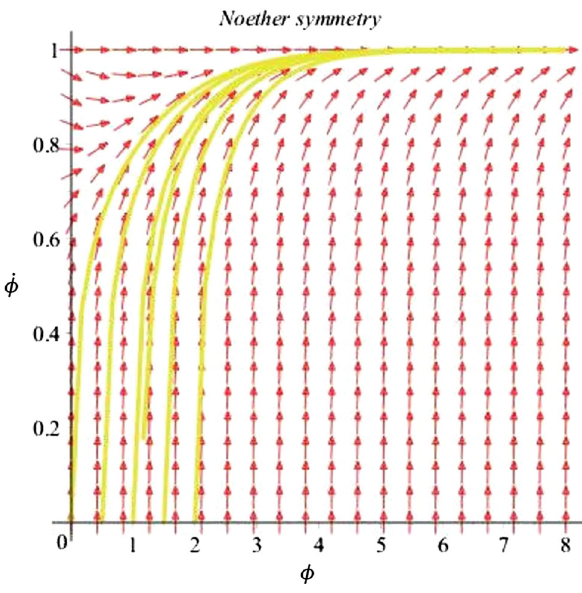
Fig. 3 Phase space diagram for V (φ) = V . e − with V . = 2 , φ . = and coupling constant f (φ) = 3 cosh ( φ φ. )